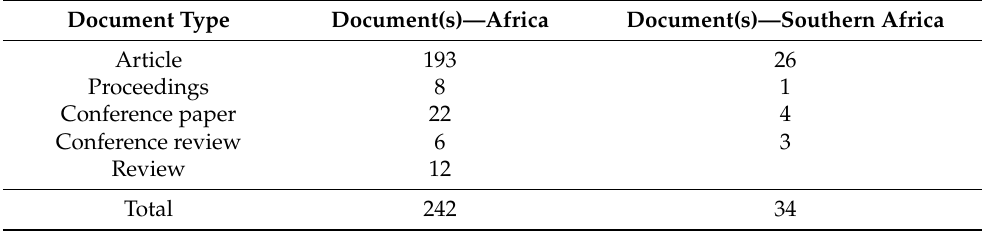
Table 2. A summary of retrieved